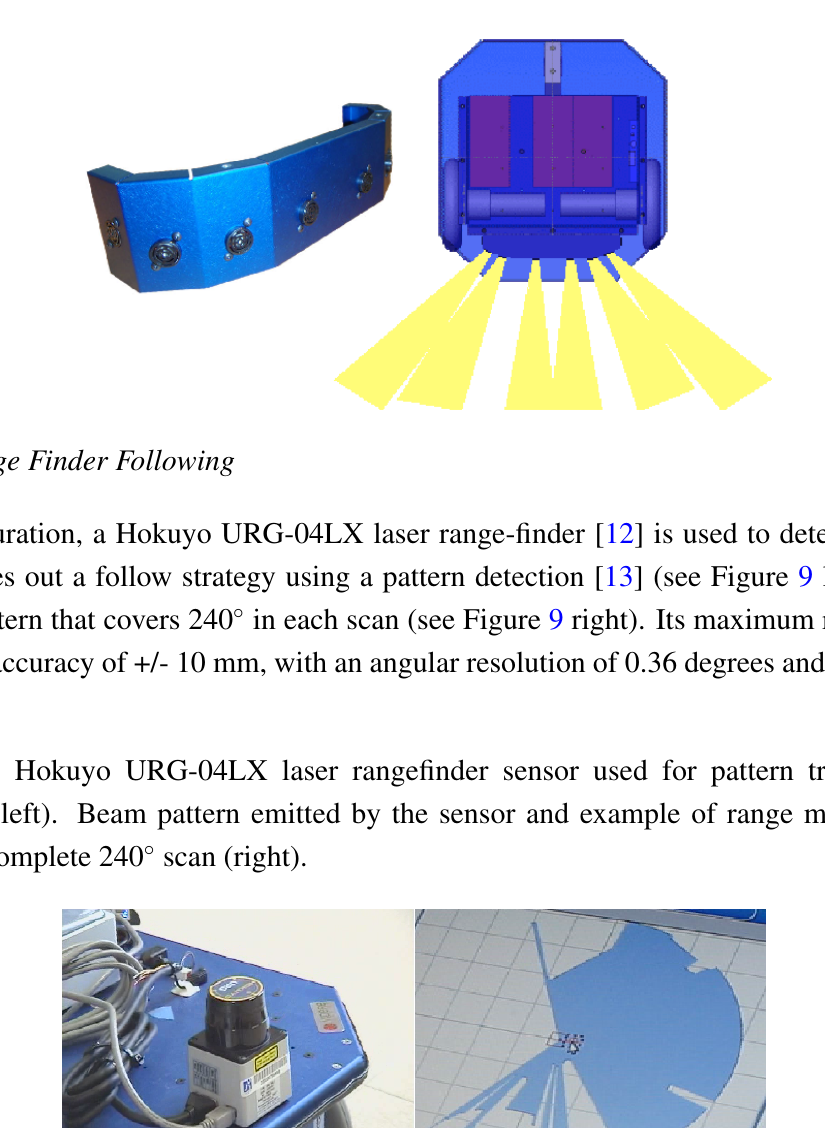
Figure 8. MaxSonar EZ1 ultrasound ring installed in the front of the Erratic Videre robot platform (left). Top view of the Erratic Videre mobile platform, showing the ultrasound pattern beam (right).